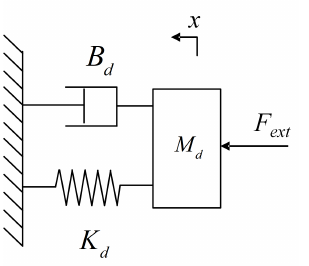
Figure 1. Impedance dynamics model.